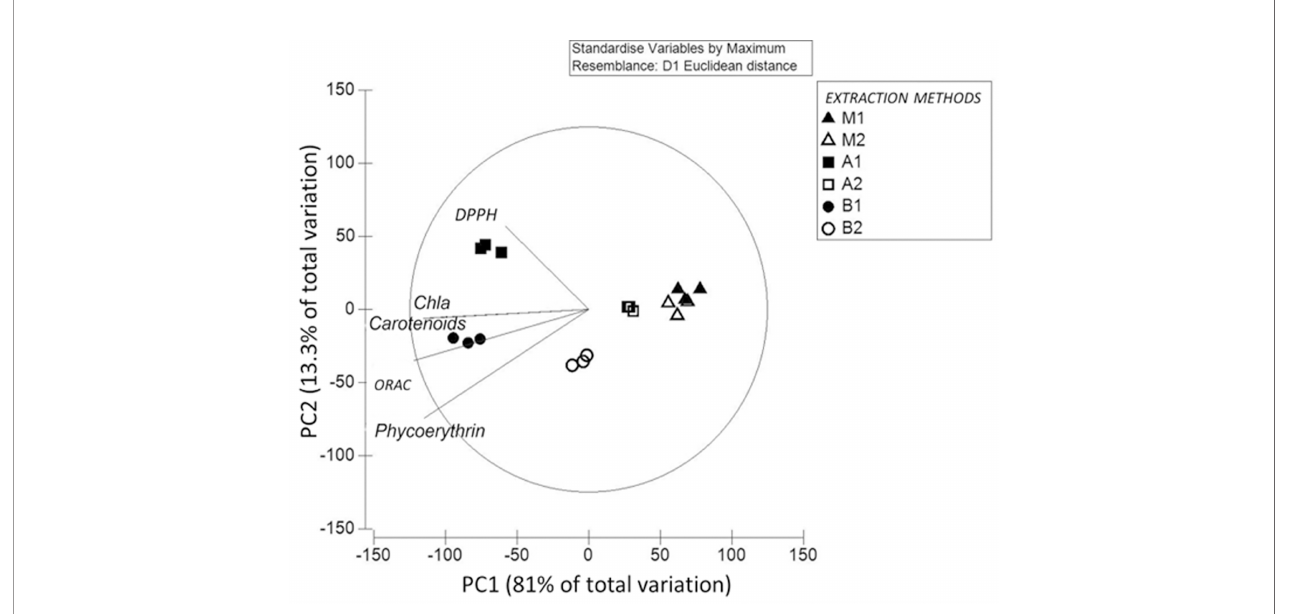
FIGURE 5 | Principal component analysis to pigments quanti fi cation and antioxidant activity in S. skottsbergii with respect to the extraction methods. M1: Maceration by water; M2: Maceration by Buffer phosphate; A1: Ultrasound by water; A2: Ultrasound by buffer phosphate; B1: High-pressure by water and B2: High- pressure by Buffer